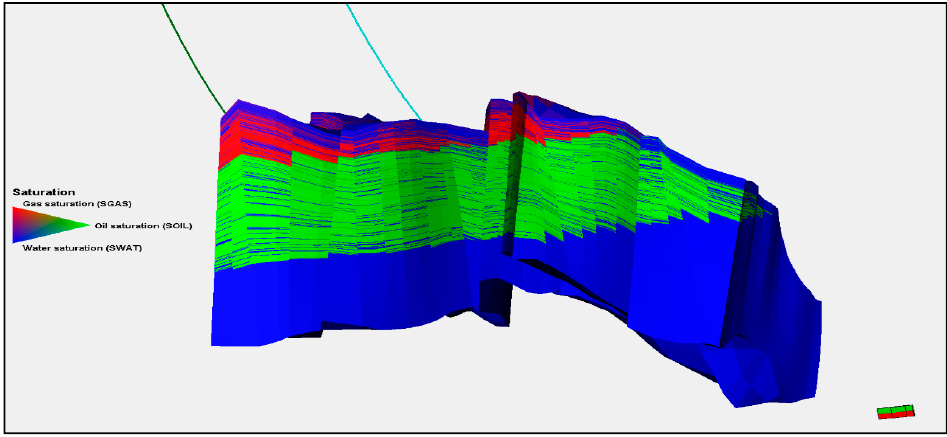
Figure 18. Vertical saturation map of the N Field Reservoir (at the start of production).